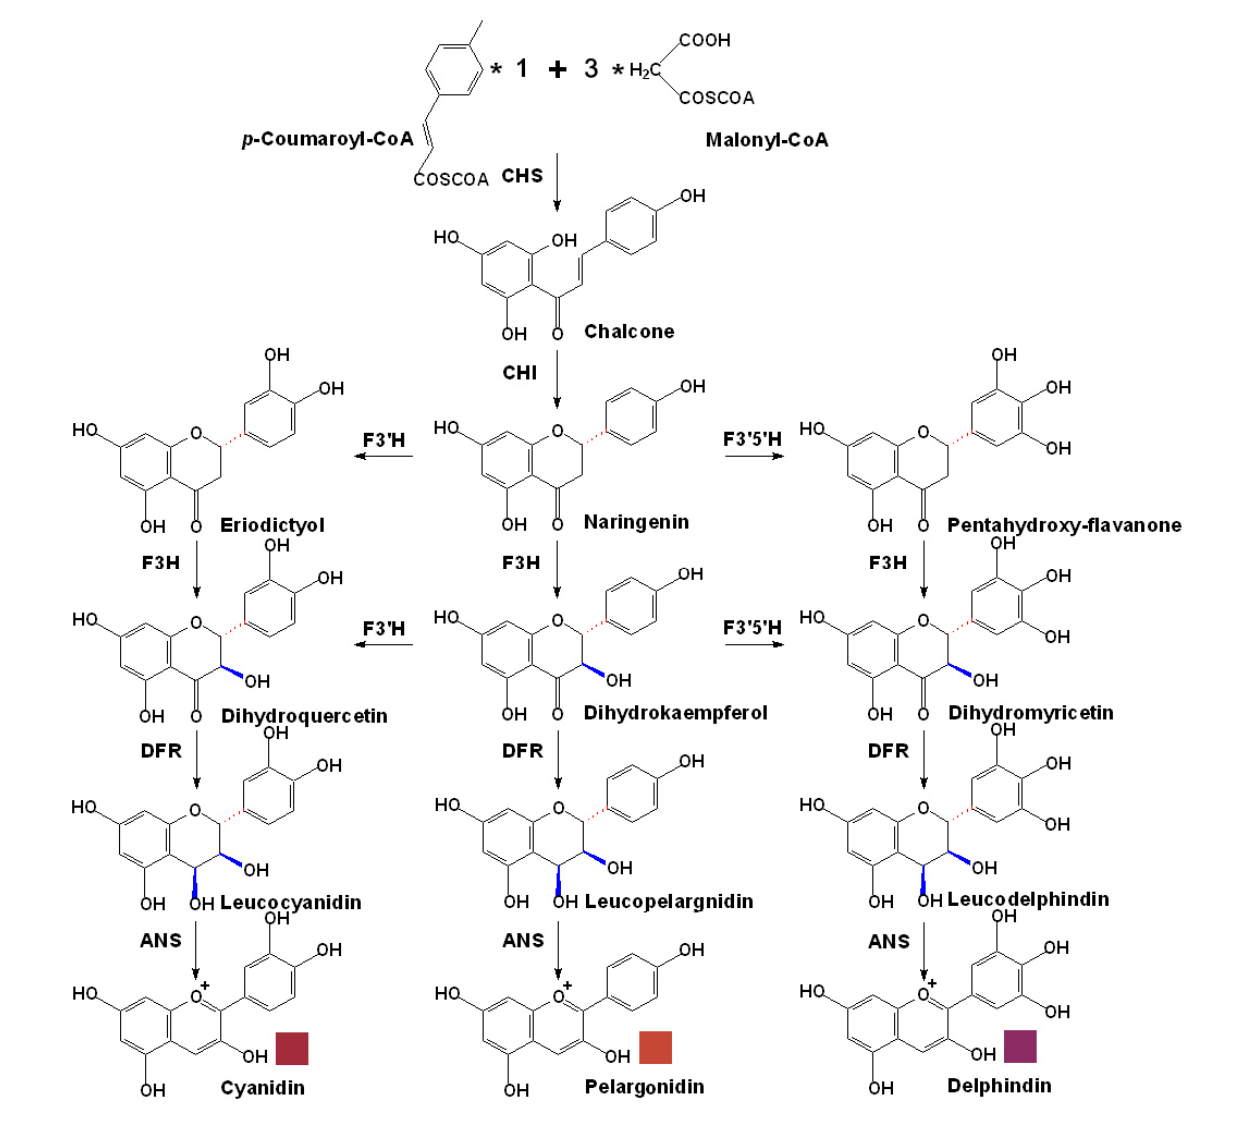
Figure 4. The basic upstream flavonoid pathway leading to the biosynthesis of colored anthocyanidins in grapes. CHS , chalcone synthase; CHI , chalcone isomerase; F3H , flavanone 3 β -hydroxylase; F3’H , flavonoid 3’-hydroxylase; F3’5’H , flavonoid 3’,5’-hydroxylase; DFR , dihydroflavonol 4-reductase; ANS , anthocyanidin synthase